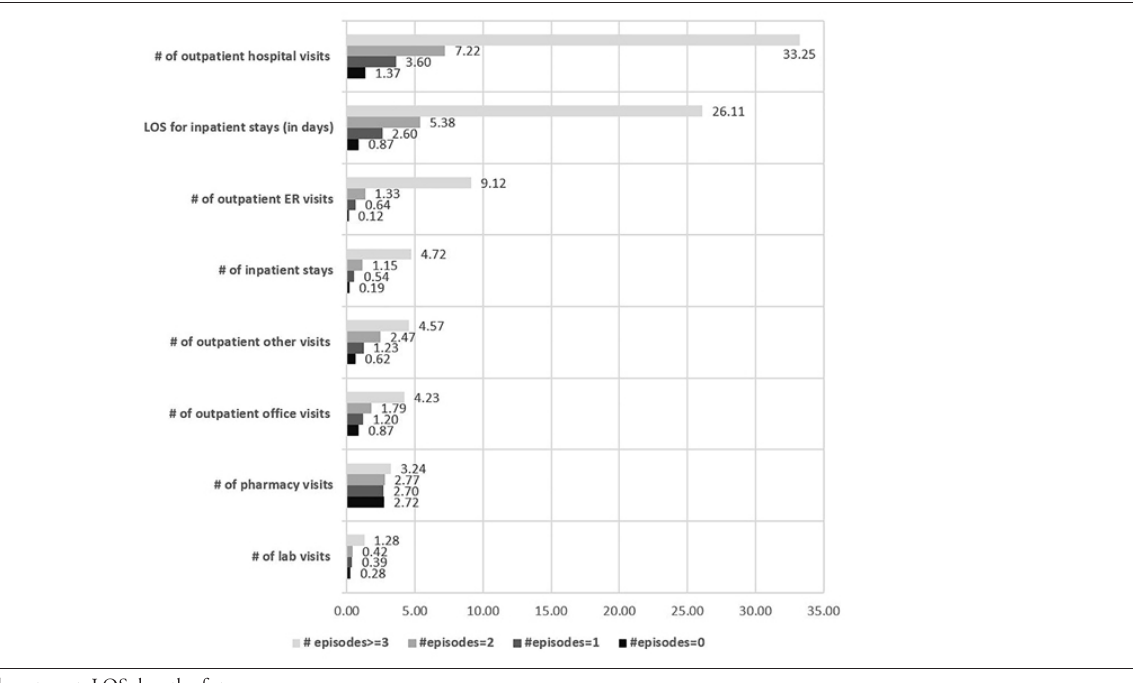
Figure 2a. SCD-related HCRU Stratified by Number of Pain Episodes in 1 Year